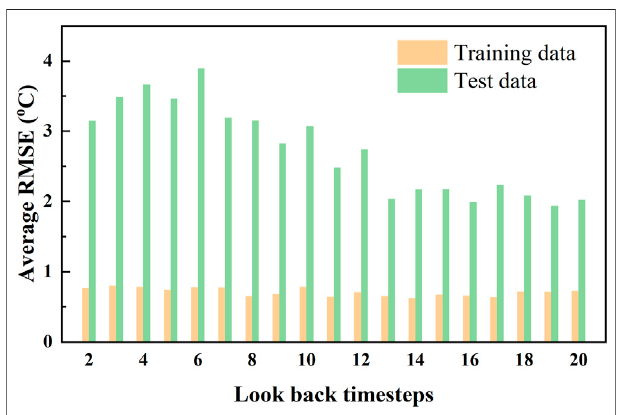
FIGURE 5 | Average RMSEs with different look-back time steps.